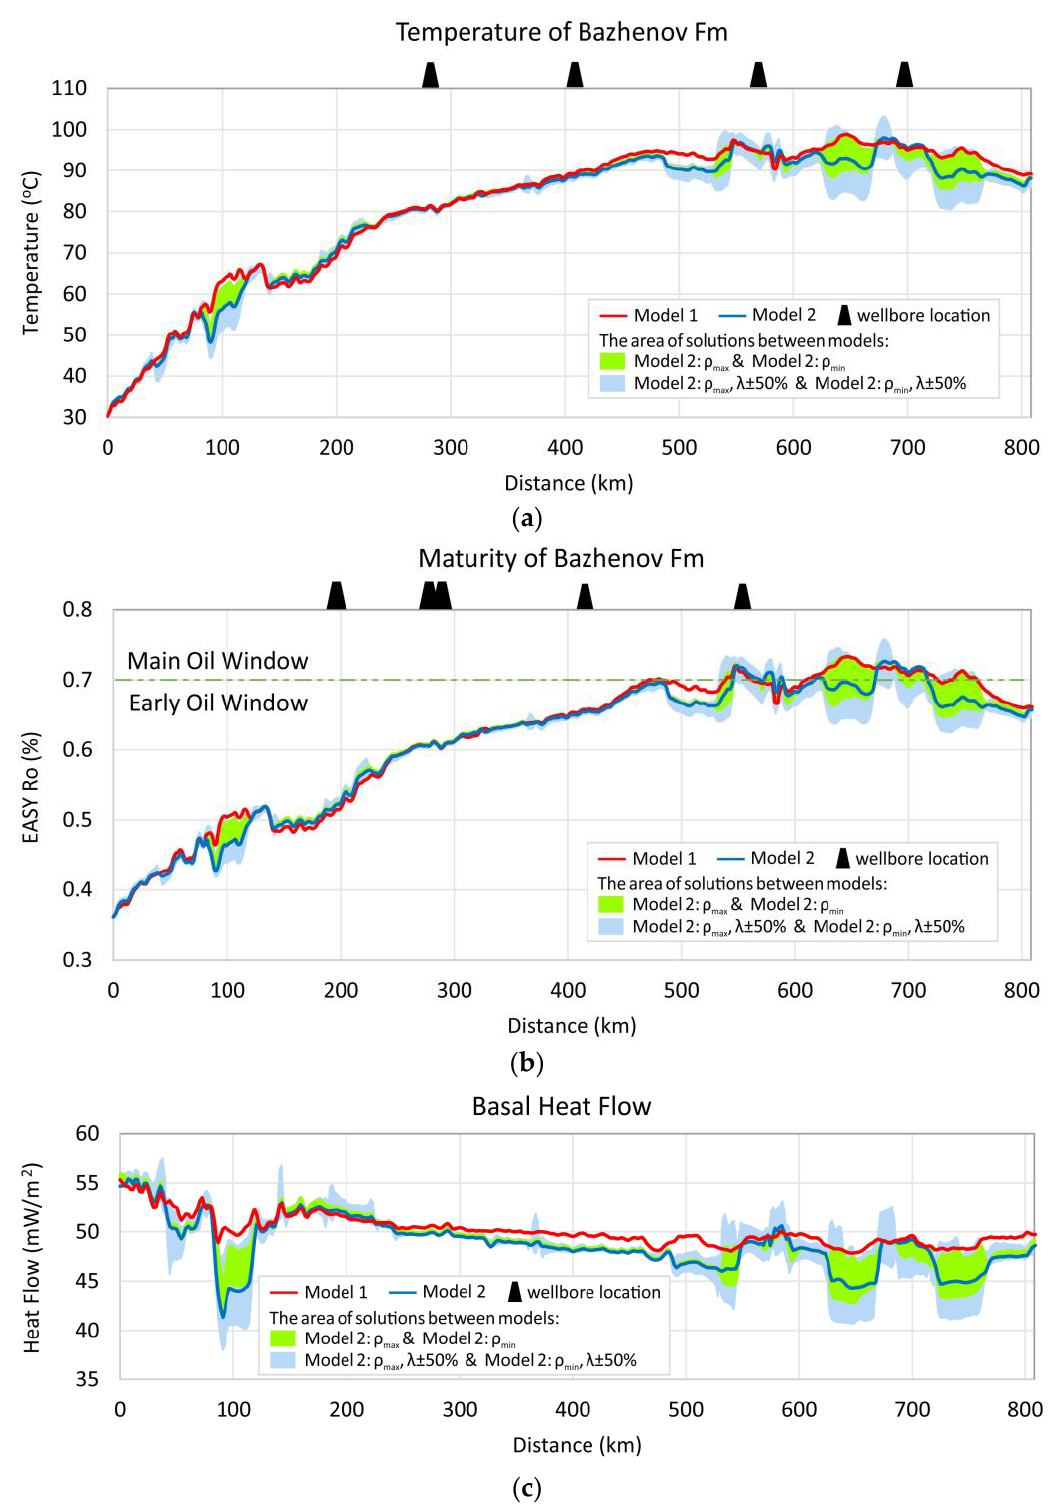
Figure 12. Calculated present-day ( a ) temperatures and ( b ) vitrinite reflectance by the EasyRo model [73] of the Bazhenov Fm surface and ( c ) basal heat flow for Model 1 and Model 2. The lower edge of the blue infill corresponds to Model 2: ρ min .